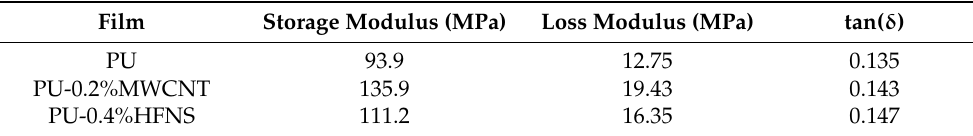
Table 2. Rheological parameters of PU-based films at 25 ◦